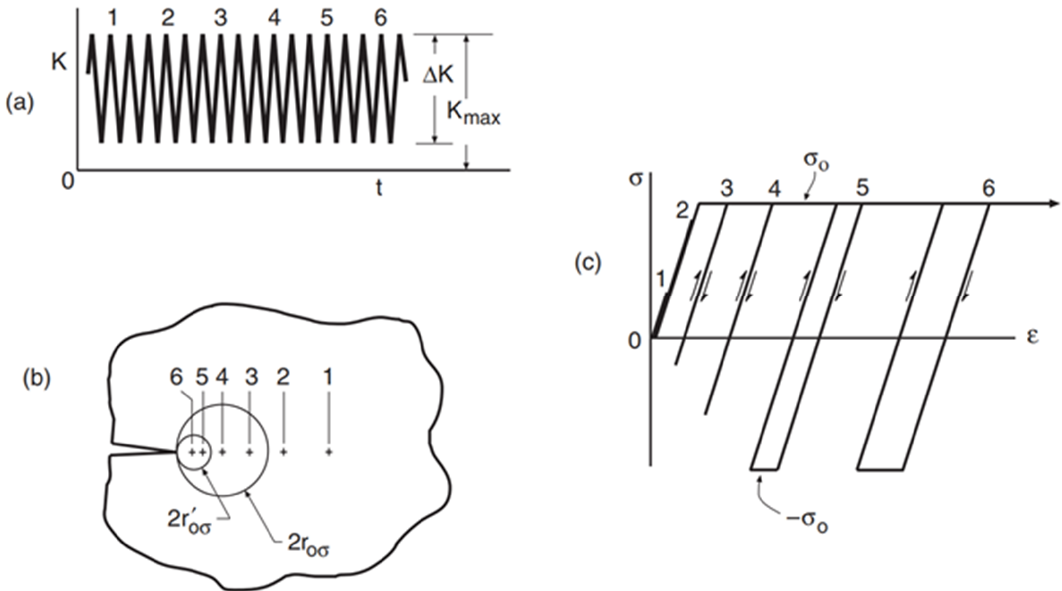
Figure 10. Stress–strain distribution at different distances from the crack tip of ideal material [32]: ( a ) Load waveform; ( b ) measure points layout; ( c ) strain–stress curves.